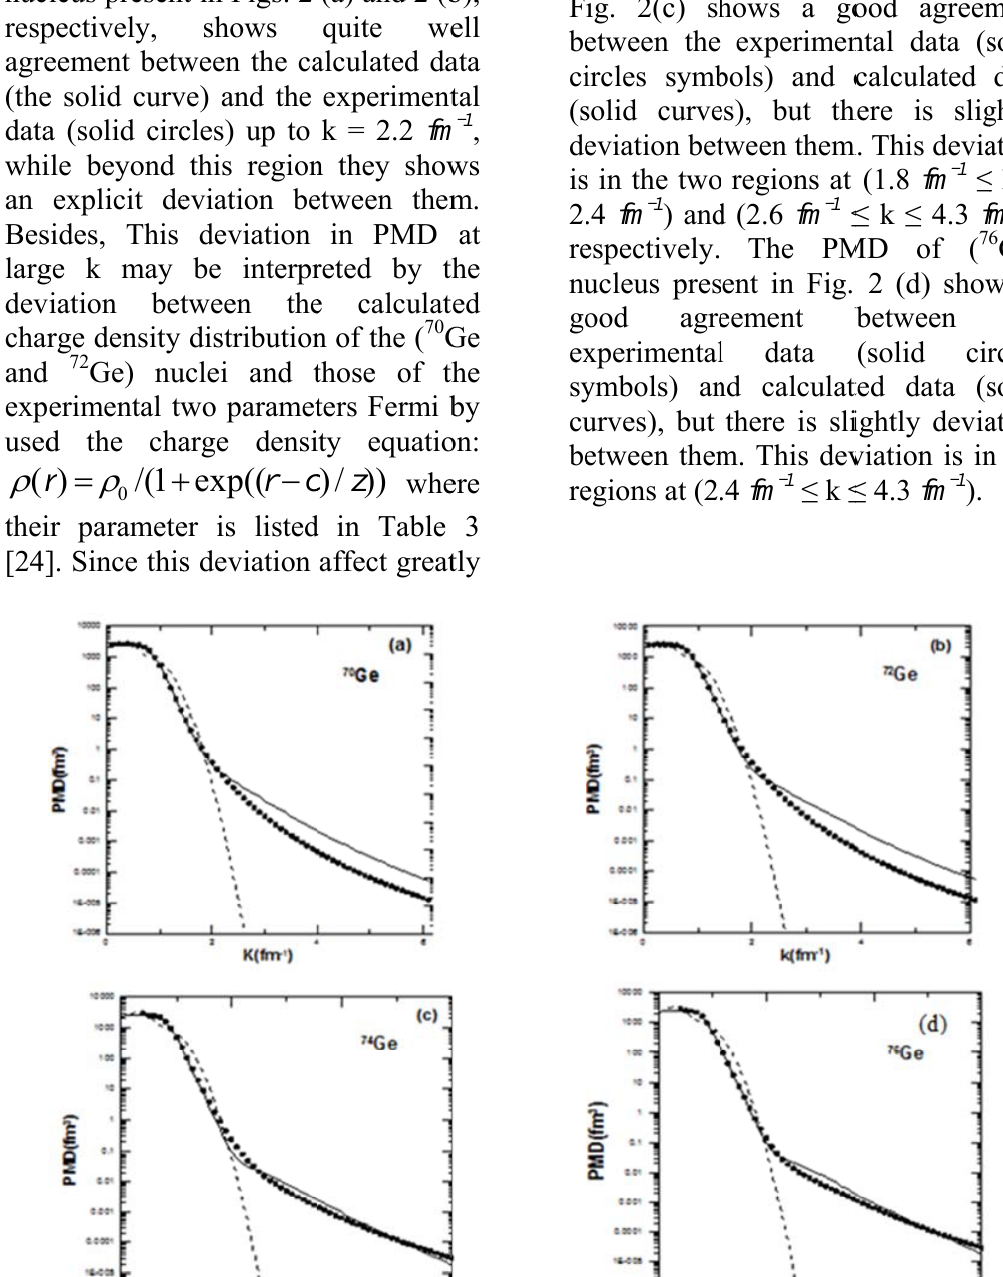
endence of P urves are th ng the single The solid ci